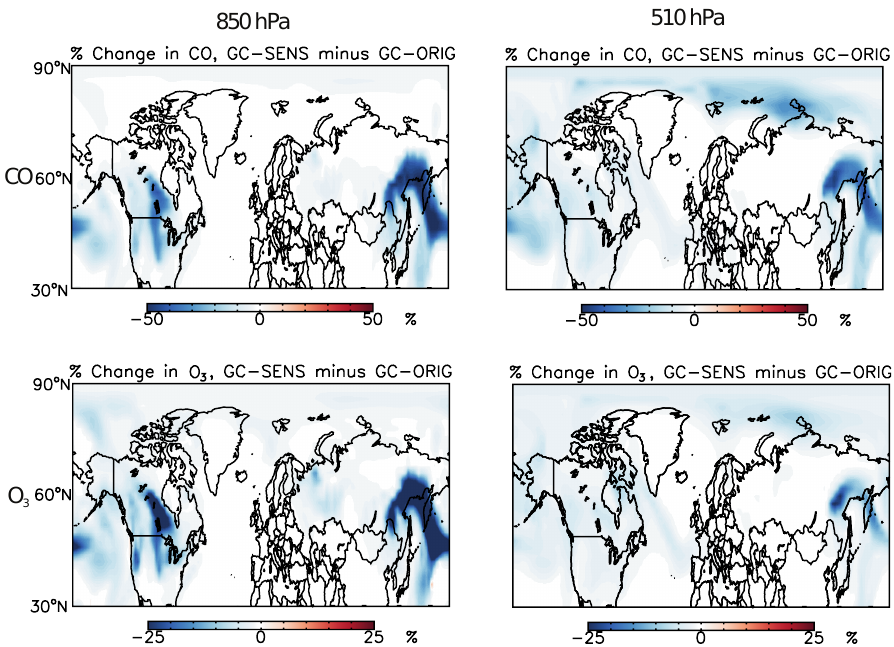
Fig. 9. Percentage differences between the mixing ratios of CO and ozone at 850hPa and 510hPa in the emissions sensitivity case (GC- SENS) minus the mixing ratios in the original GEOS-Chem simulation (GC-ORIG) for 4 July 2008. Note that the different emissions started on 15 June